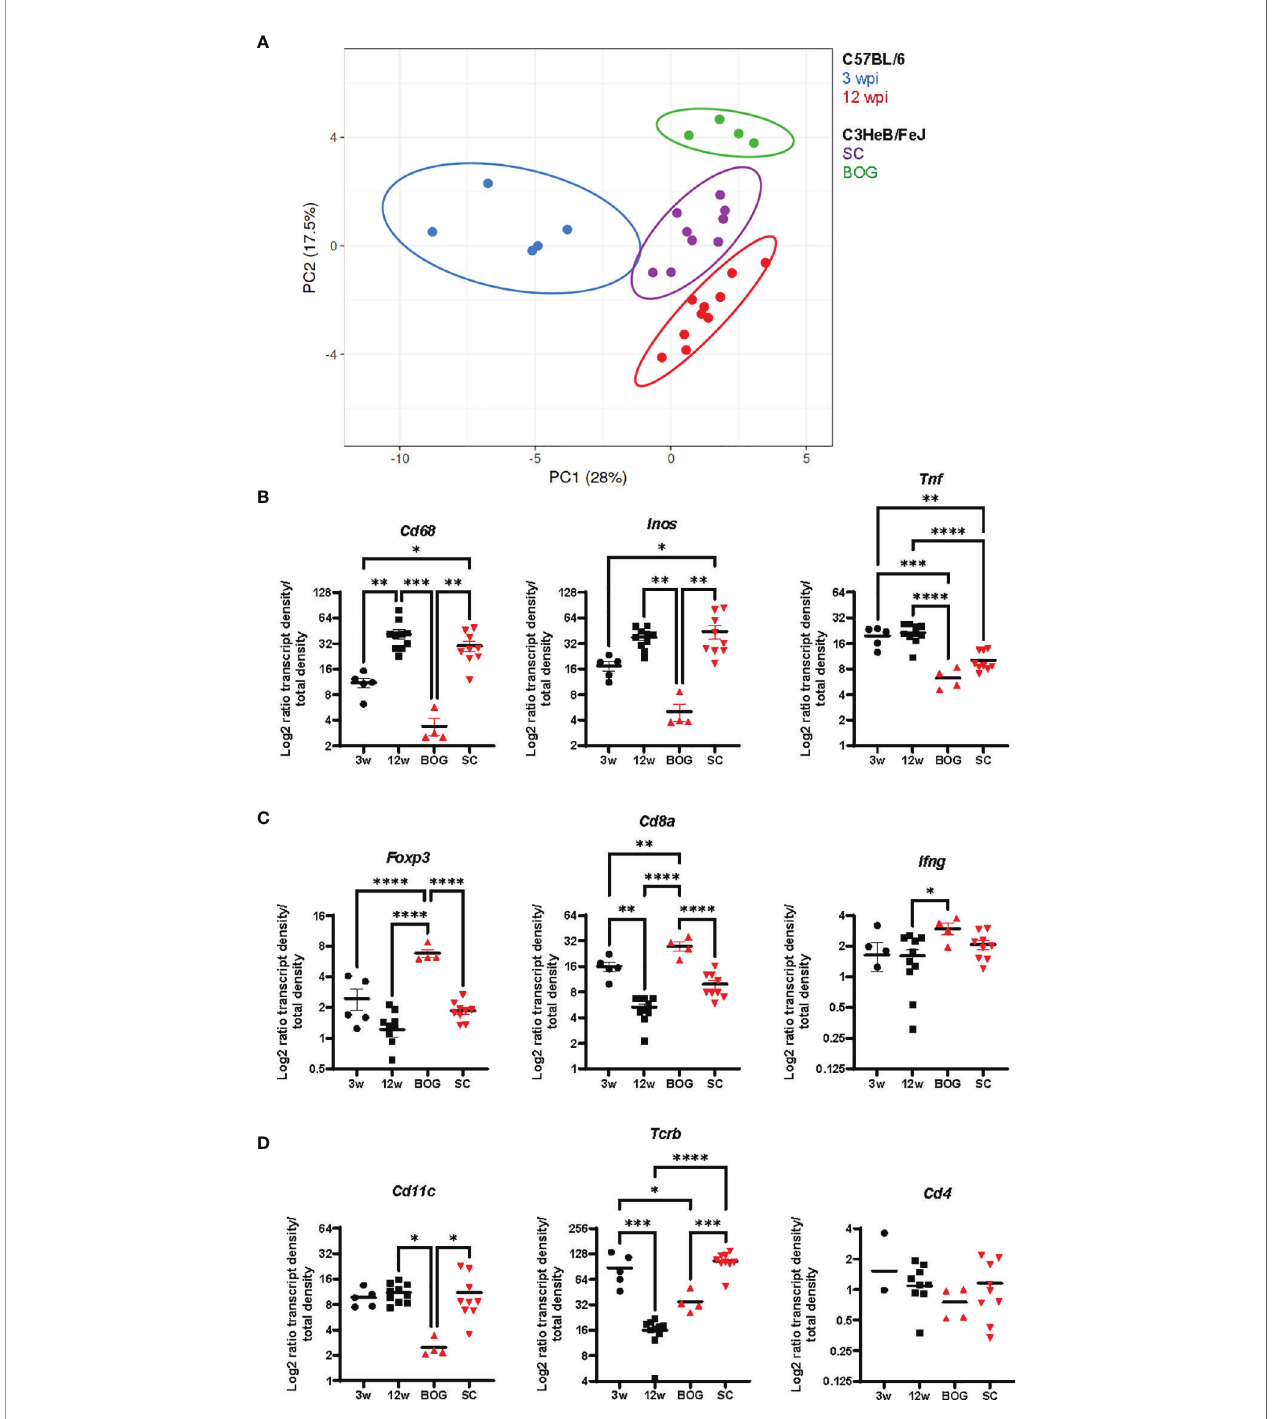
FIGURE 7 | Bacteria cluster comparison of C57BL/6 and C3HeB/FeJ mice. (A) Principal component analysis of the density ratio of immune transcripts in bacteria clusters of C57BL/6 and C3HeB/FeJ mice is shown. Clusters were identi fi ed as described for Figures 5 , 6 with 3 wpi C57BL/6 (blue, n = 5), 12 wpi C57BL/6 (red, n = 10), C3HeB/FeJ SC (purple, n = 9), and BOG C3HeB/FeJ (green n = 4). The ellipse around the clusters indicates the area in which 95% of the samples would be located based on gaussian distribution. (B – D) Density ratios for indicated transcripts of the same clusters as in A are displayed: (A) Cd68, Inos , and Tnf ; (B) Foxp3, Cd8a , and Ifng ; (C) Cd11c, Tcrb , and Cd4 . Mean density ratios ± SEM and individual values are shown, and signi fi cant differences are indicated (ANOVA, * for p < 0.05, ** for p < 0.01, *** for p < 0.001, and **** for p <